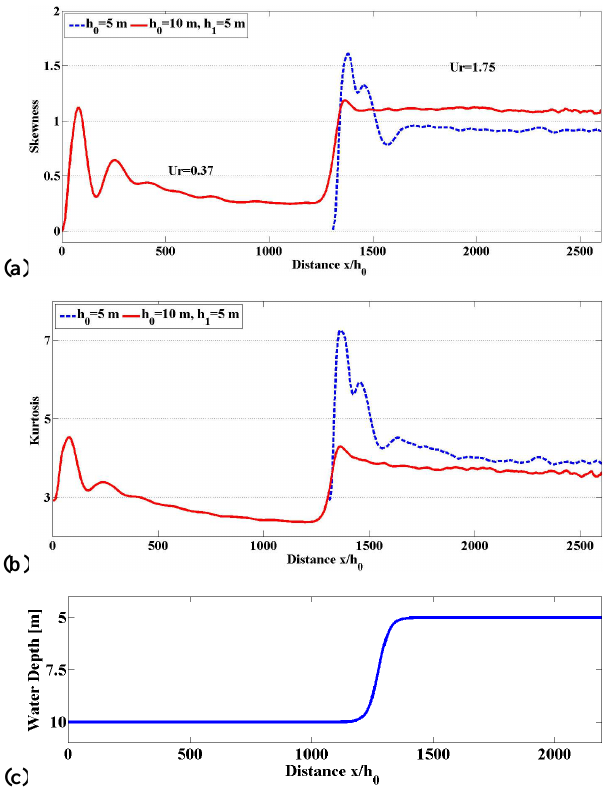
Figure 2. Variation of the skewness (a) and kurtosis (b) in the water of variable depth with initial Fig. 2. Variation of the skewness (a) and kurtosis (b) in the water value Ur = 0.37 (dashed line). The same variation in the water of constant depth h 0 = 5 m with of variable depth with initial value Ur =0.37 (solid line). The same variation in the water of constant depth h 0 = 5m with Ur =1.75 Ur = 1.75 (solid line). Variable depth profile with L = 30 h 0 (c). (dashed line). Variable depth profile with L = 30 h 0 (c) . An increase of the wave steepness ( ε = 1 ⋅ 10 -2 ) leads, as expected, to more significant deviations of the skewness and kurtosis from the values of the Gaussian state (Fig. 3). As opposed to the previous case ( Ur = 1.75), the comparison with the simulation for a constant depth in the case of steeper waves ( Ur = 3.5) manifests two different regimes of the steady state at the depth h = 5 m: large transition zone for a constant depth condition and shorter transformation to a steady state